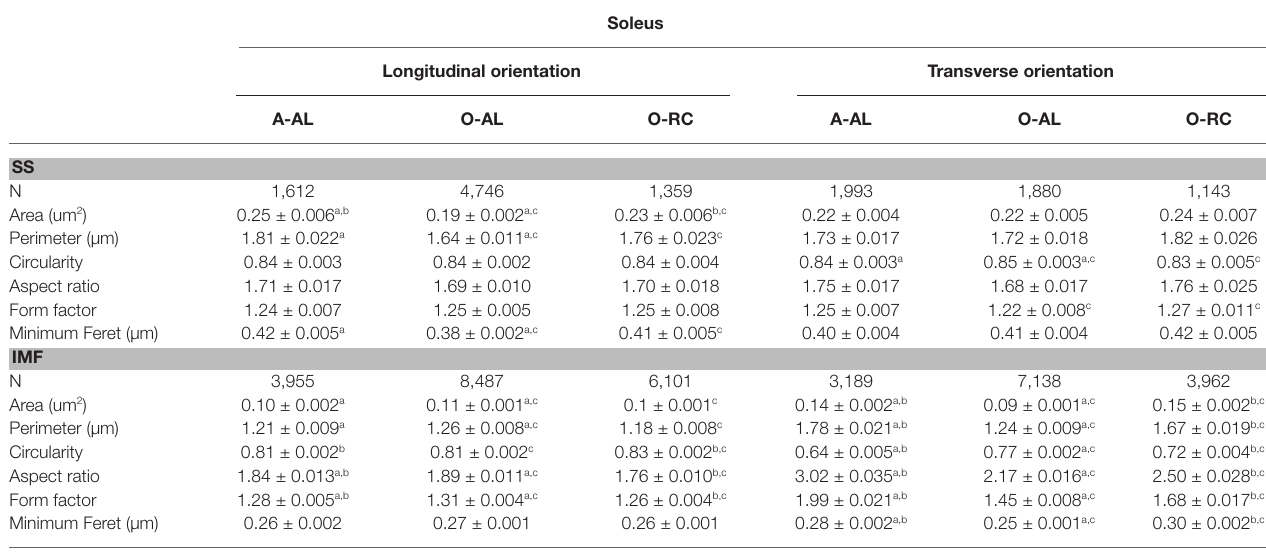
TABLE 1 | Effects of aging and caloric restriction on morphological parameters and shape descriptors of subsarcolemmal and intermyofibrillar mitochondria in the soleus.